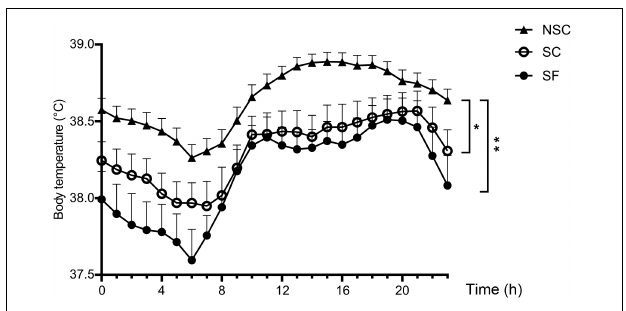
FIGURE 8 | Body temperature. Body temperature was significantly higher in non-stressed (NSC) than in stressed (SF and SC) animals. N = 12/group, mean ± SEM, two-way ANOVA, ∗ p < 0.05, ∗∗ p <